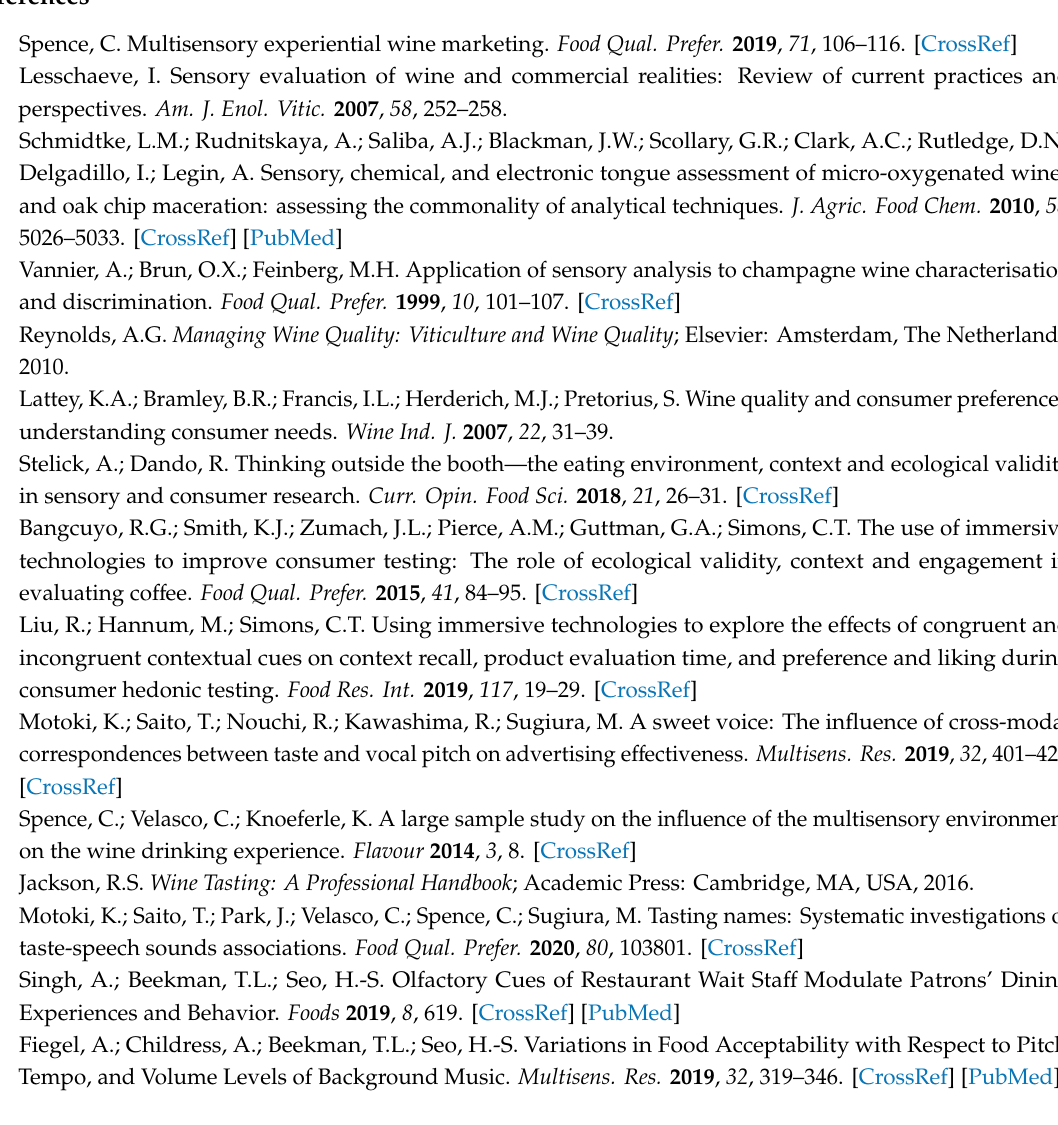
Table S1: Correlation analysis (r)* of the variables measured for the wine sample in the traditional booth environment, Table S2: Correlation analysis (r)* of the variables measured for the wine sample in the bright restaurant environment, Table S3: Correlation analysis (r)* of the variables measured for the wine sample in the dark restaurant environment, Table S4: Correlation analysis (r)* of the variables measured for the wine sample in the bright VR environment, Table S5: Correlation analysis (r)* of the variables measured for the wine sample in the dark VR